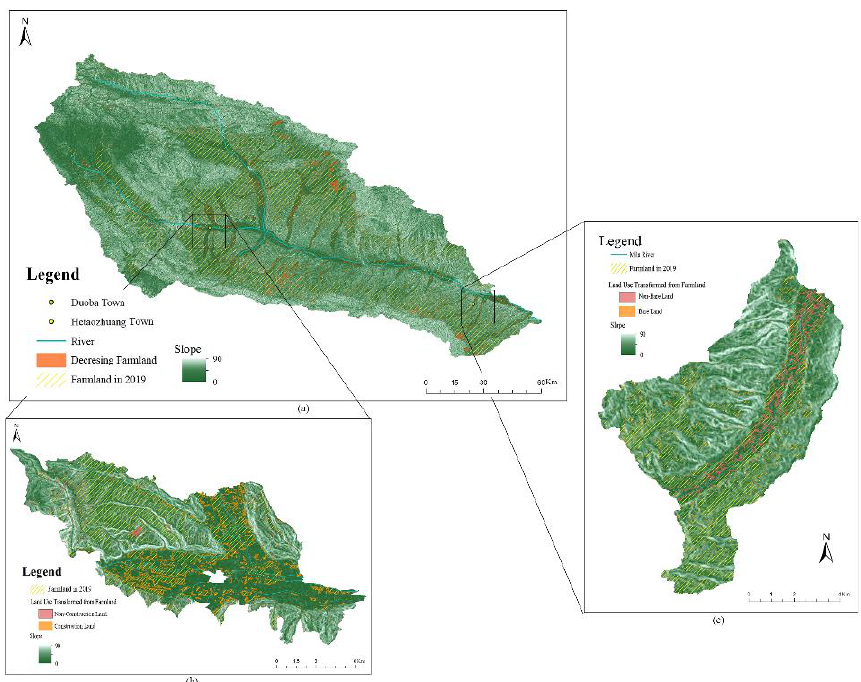
Figure 5. Results of risk analysis of farmland loss: ( a ) Huangshui Basin; ( b ) Duoba Town in Huangzhong District; ( c ) Hetaozhuang town in Minhe County. (WGS84, 1: 975 000)